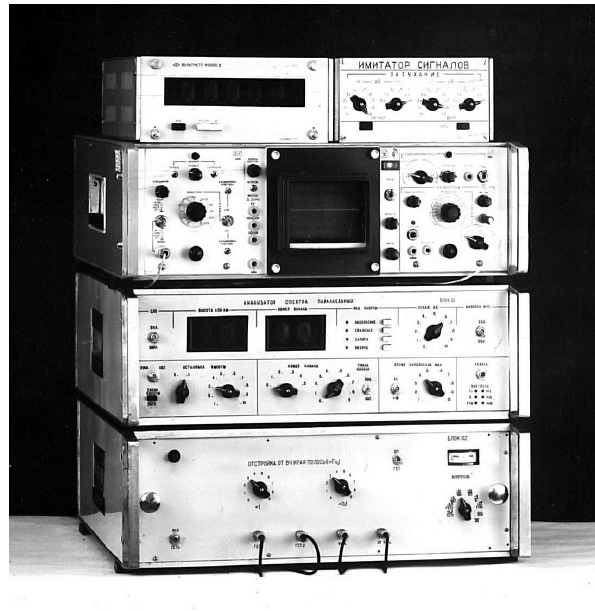
Figure 2. The first 40-channel analog spectrograph.